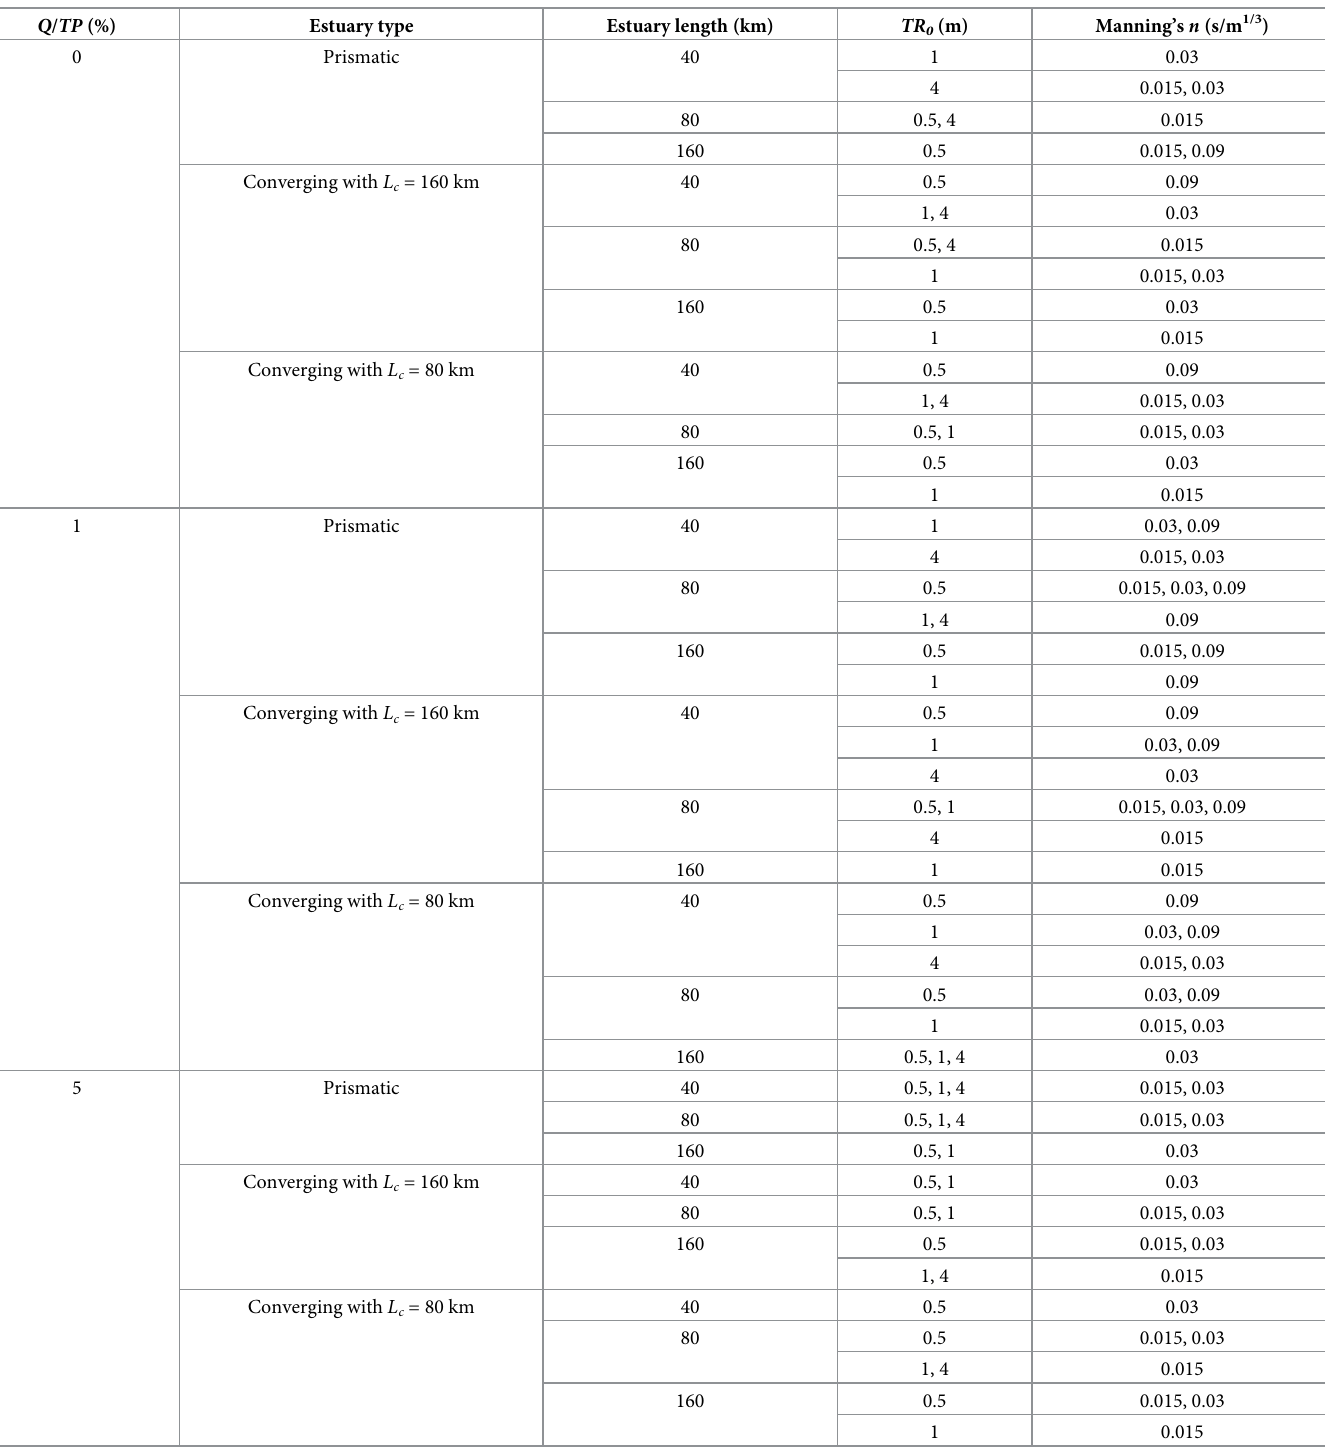
Table 3. Various estuary types with different boundary conditions that are likely to experience increasingly tidal range amplification under SLR. Q / TP